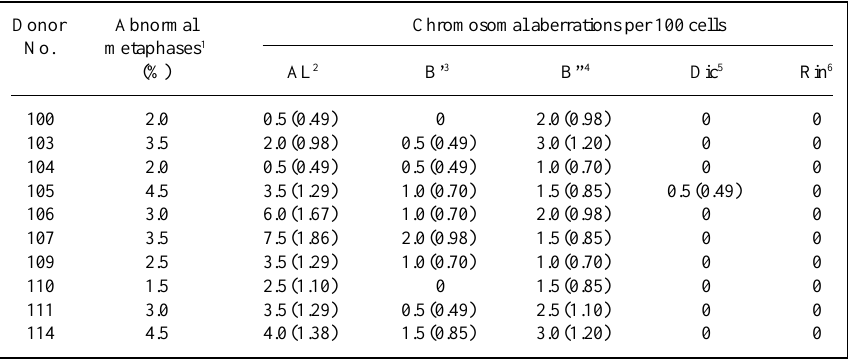
Table III - Frequency of chromosomal aberrations found in controls. Standard error of the mean is indicated in parentheses. A total of 200 metaphases per donor were analyzed. Donor Abnormal Chromosomal aberrations per 100 cells